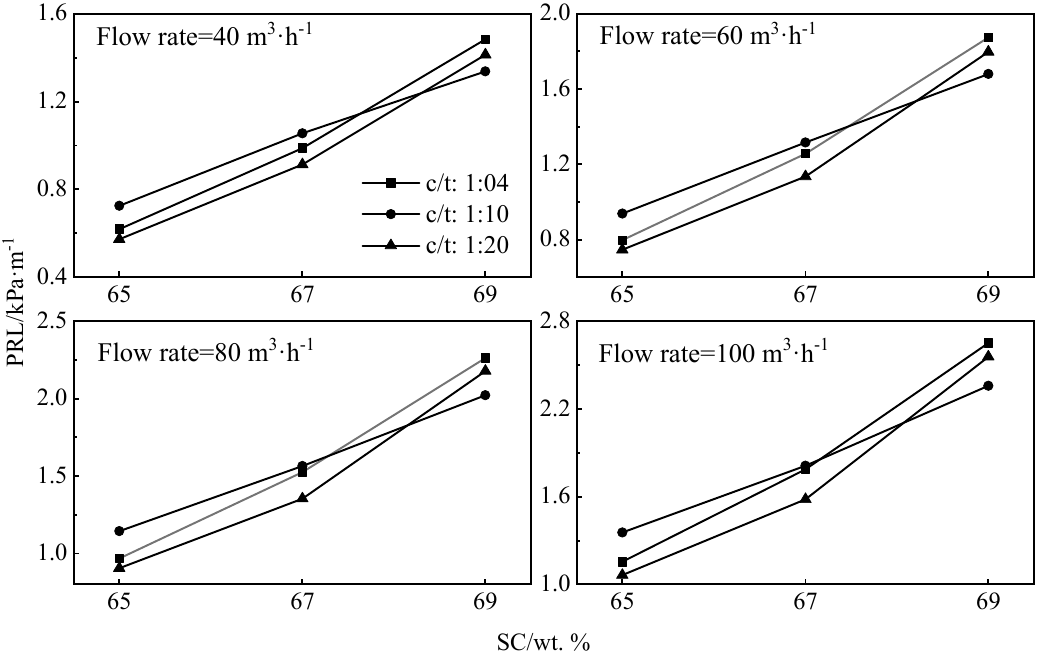
Figure 8. Relationship between pipeline resistance loss (PRL) and SC values.